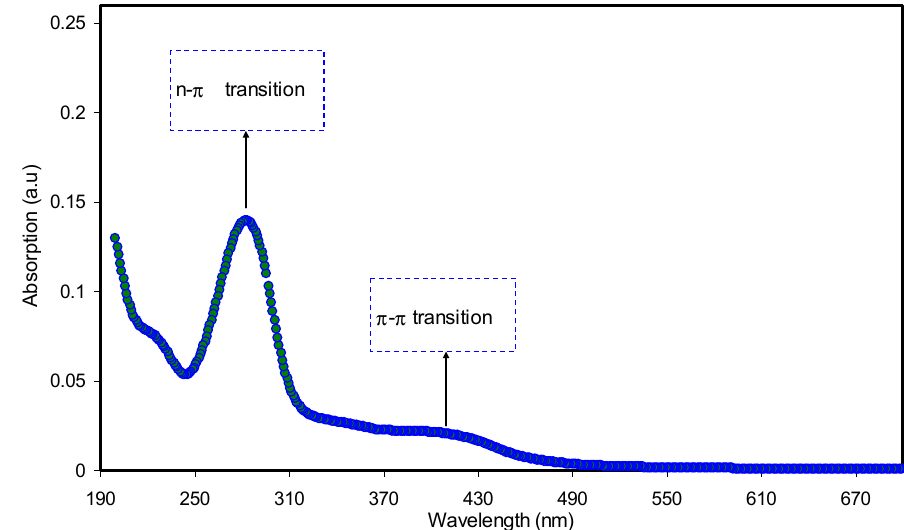
Figure 4. The UV – Vis absorption spectra for pure CNDs solution.